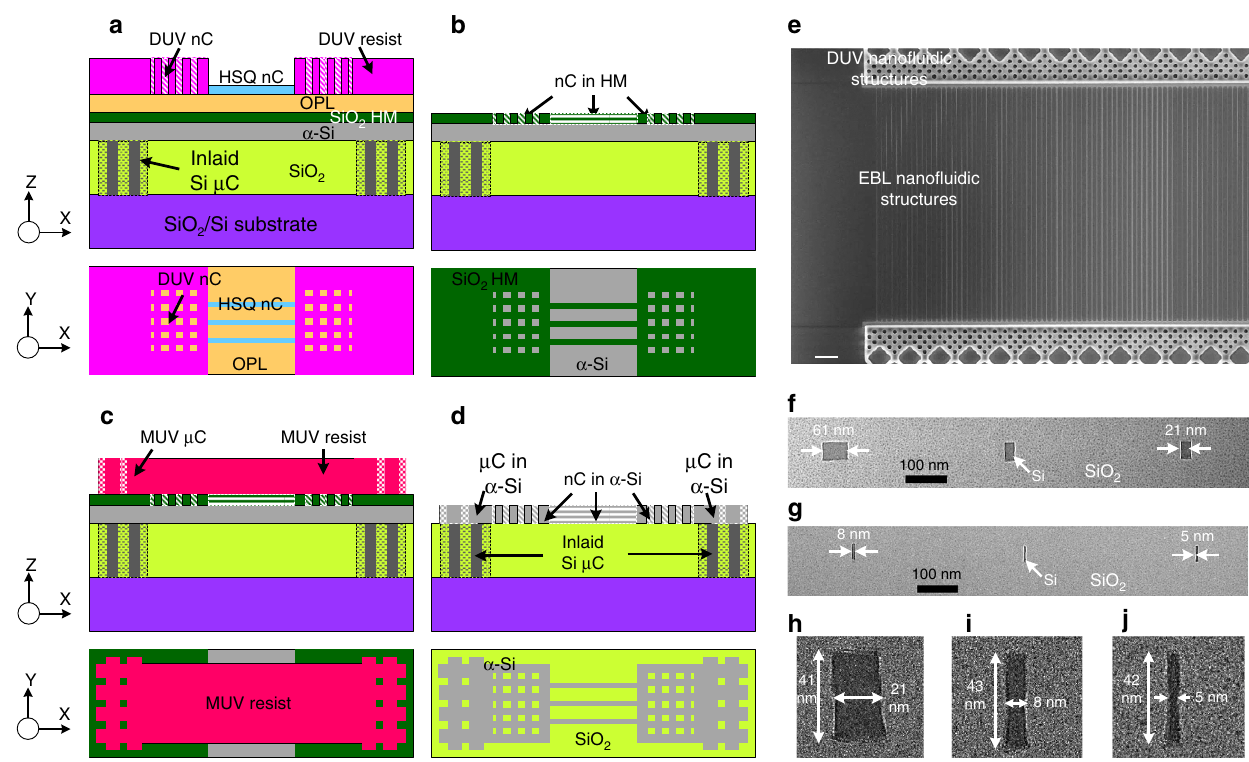
Figure 2 | Three-level mixed lithography to fabricate Si sacrificial nanostructures. ( a – d ) Fabrication scheme of patterning process (top: cross-sectional view in X–Z plane; bottom: top view in X–Yplane): ( a ) Combined nanopatterning of nanofluidic channel structures (nC) in deep ultraviolet (DUV) resist and EBL-defined hydrosilsesquioxane (HSQ) resist on an organic planarization layer (OPL)/SiO 2 HM (hard mask)/ a -Si film stack, with inlaid Si microchannels ( m C) embedded and planarized in the substrate; ( b ) Nanofluidic structures transferred to HM layer; ( c ) MUV-patterned m C in resist; ( d ) a -Si fluidic structures with critical dimensions defined by MUV, DUV and EBL. ( e - j ) Fabricated nanofluidic structures: ( e ) Scanning electron microscope (SEM) image showing well-aligned DUV and EBL fabricated nanostructures before SiO 2 capping; ( f - j ) Cross-sectional TEM images showing as small as o 5nm wide Si nanostructures in SiO 2 capping layer. Scale bar in figure ( e ) is 2 m